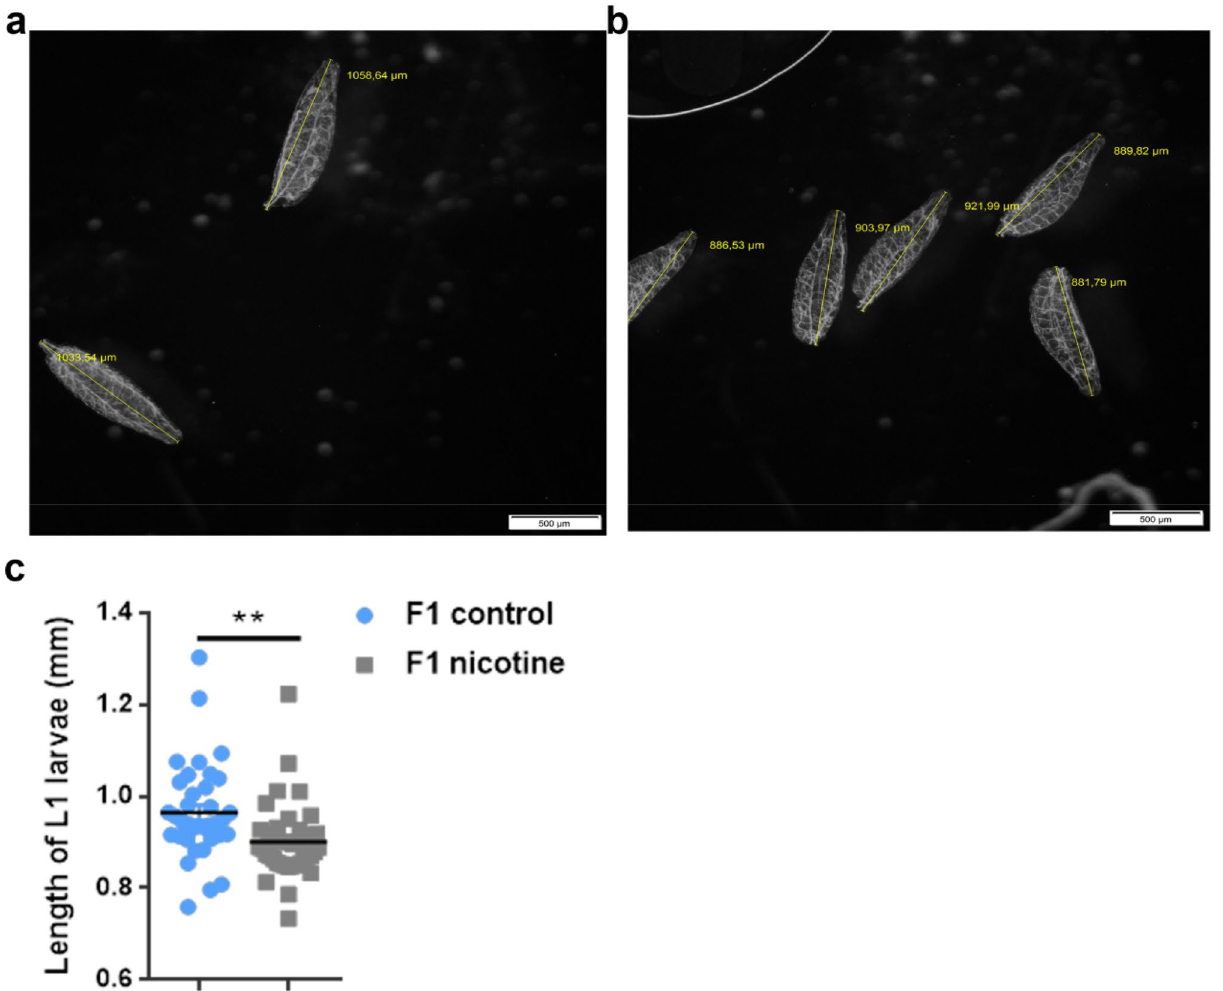
Figure 4. The length of F1 1st instar larvae in the control and nicotine-exposed groups. ( a , b ) Stereomicroscope image of the 1st instar larvae from the control ( a ) and maternal nicotine-treated ( b ) groups analysed using the image software cellSens (yellow line represents the measurement of the body length) ( c ) Quantification of the length (μm) of 1st instar larvae from maternal nicotine-treated (gray) and control (blue) groups. Values are mean + /-SEM, unpaired t-test, **p < 0.01, n = 3 independent experiments. Bar represents 500